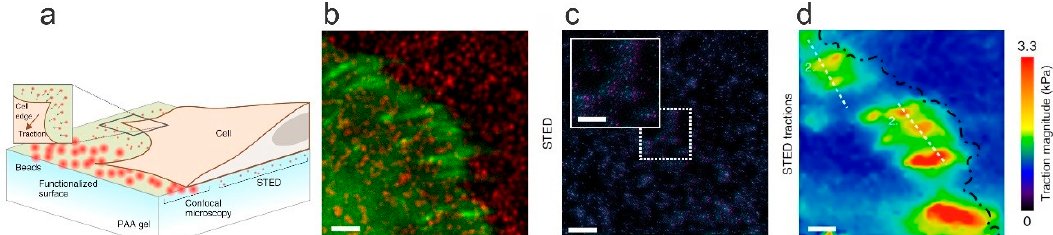
Figure 10. Illustration of traction force microscopy as realized by integrating fluorescent NPs in an elastic matrix (polyacrylamide) and spatio-temporally monitoring their position using either confocal or high resolution (stimulated emission depletion) microscopy to map out deformation and local forces exerted by growing cells on the substrate ( a ) and the process illustrated to map the traction magnitude exerted by growing HeLa cells on an acrylamide gel ( b – d ) using STED-Traction Force Microscopy (STFM). The change in the location of the embedded nanoparticles due to the release of traction from the HeLa cells ( c ) and calculated map of traction magnitude on the hydrogel (d) over the same region of interest as shown in ( b ). The scale bar is 2 µ m ( b – d ). The paxillin in the focal adhesion points of HeLa was labelled with EGFP and 40 nm red fluorescent beads were embedded in the AAm hydrogel ( b ). STED imaging of the positions of the fluorescent beads embedded in the gel under the cell shifted from before (cyan) to after (magenta) treatment with trypsin-EDTA to relax the traction force ( c ) and used as a basis for the analysis of the traction force ( d ). Adapted with permission from Colin-York, H., Eggeling, C.; Fritzsche, M. Dissection of mechanical force in living cells by super-resolved